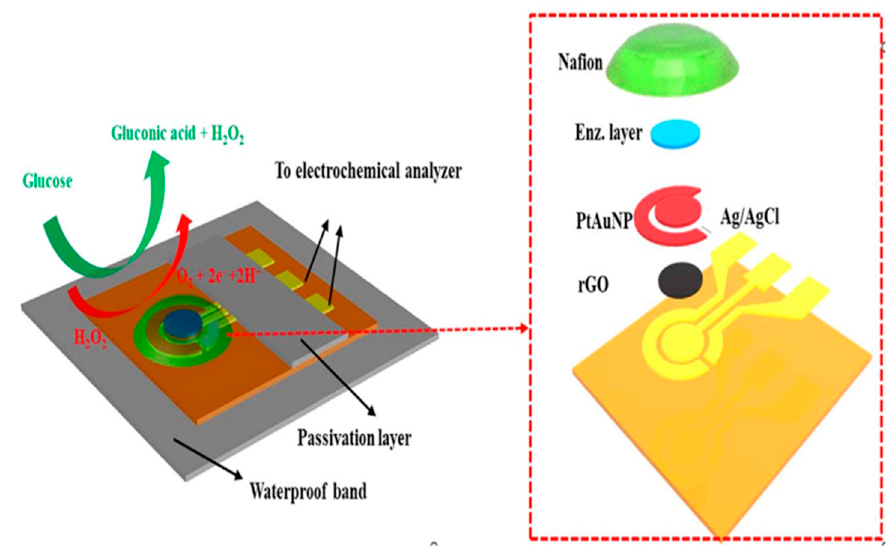
Figure 15. Schematic drawing of the entire human sweat − based wearable glucose sensor, along with an exploded view [114]. Copyright: Elsevier B.V. Table 4. Summary of the amperometric sensors combining natural enzymes with nanozymes.